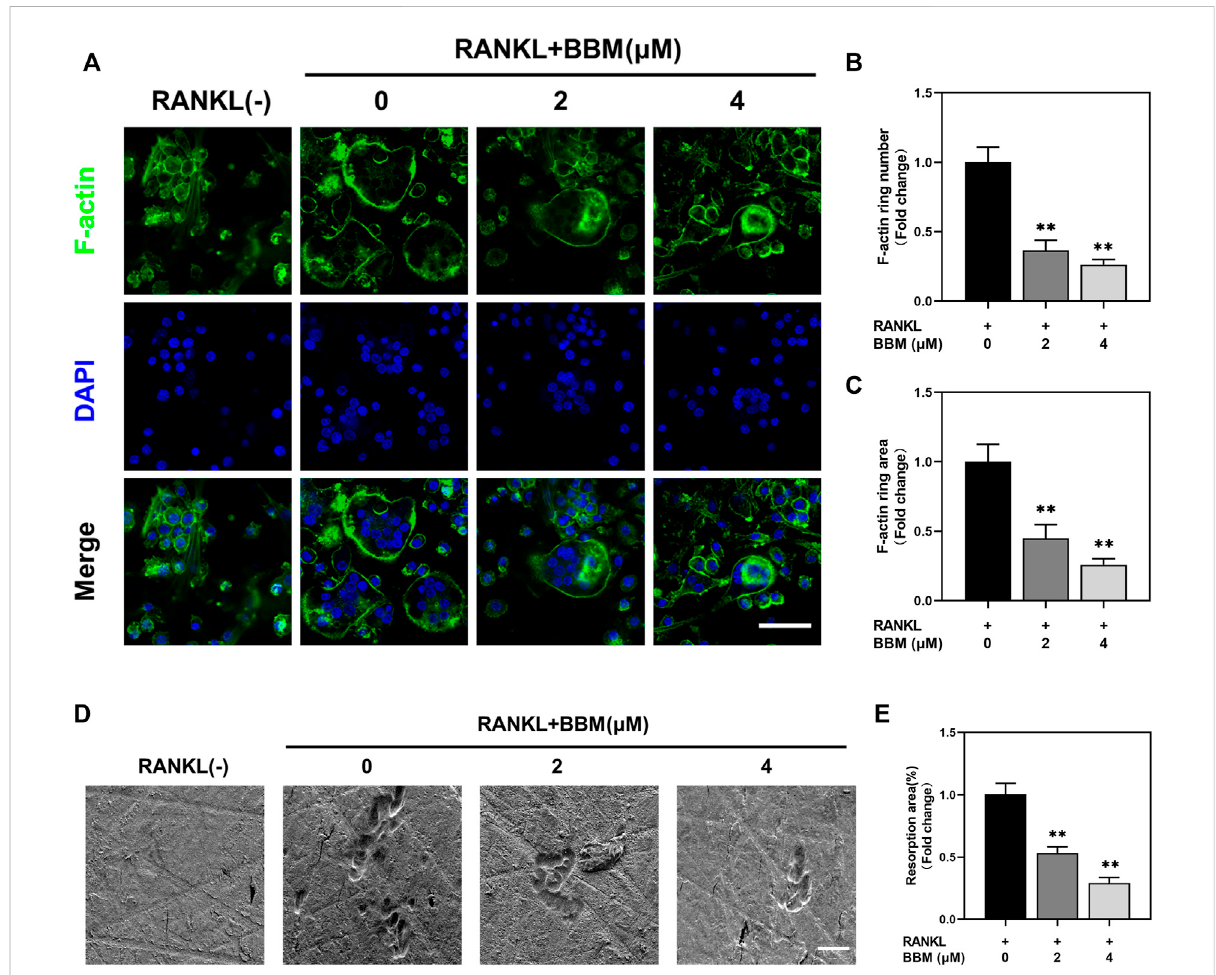
FIGURE 2 BBM inhibits RANKL-induced F-actin ring formation and osteoclast resorption function in vitro . (A) Representative confocal images of F-actin ring staining of BMMs cultured on bone slides with or without RANKL (50 ng/ml) and BBM (0, 2, and 4 μ M) for 5 – 7 days (scale bar = 50 μ m). (B – C) Quantitative analysis of the number (B) and area (C) of F-actin rings. (D) Representative SEM images of resorption pits on bone slides (scale bar = 50 μ m). (E) Quantitative analysis of the resorption area. * p < 0.05 and ** p < 0.01 compared to the control